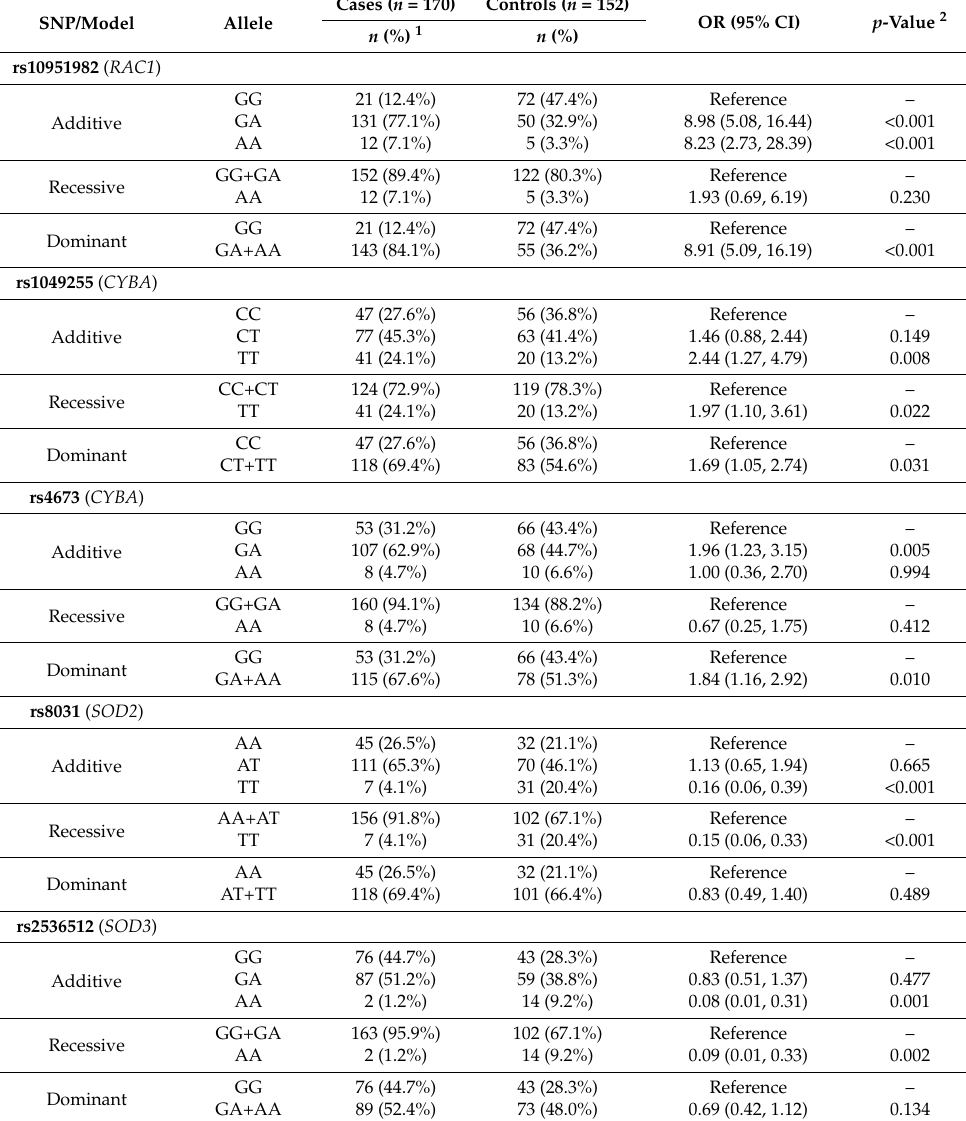
Table 4. Crude associations between the top five SNPs and melanoma